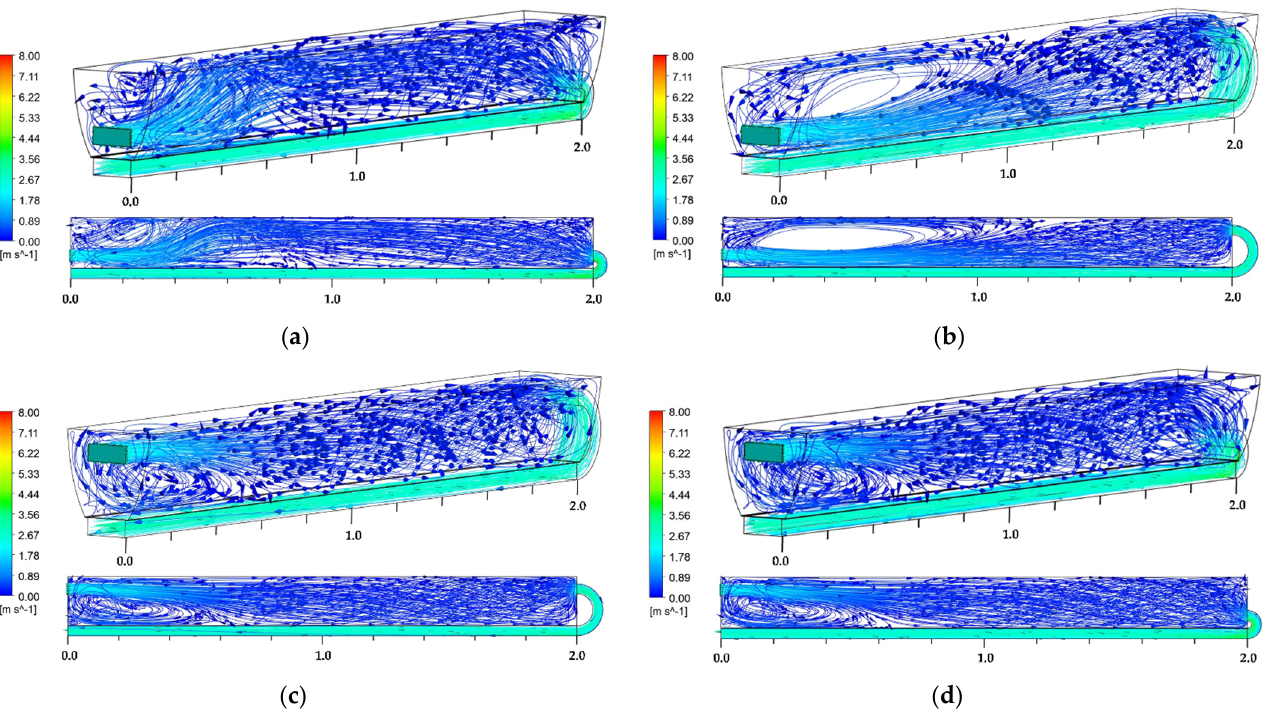
Figure 4. Streamlines at the collector cross-section with air mass flow 1: 0.01 kg/s. ( a ) Down–Down; ( b ) Down–Up; ( c ) Up–Up; ( d ) Up–Down.